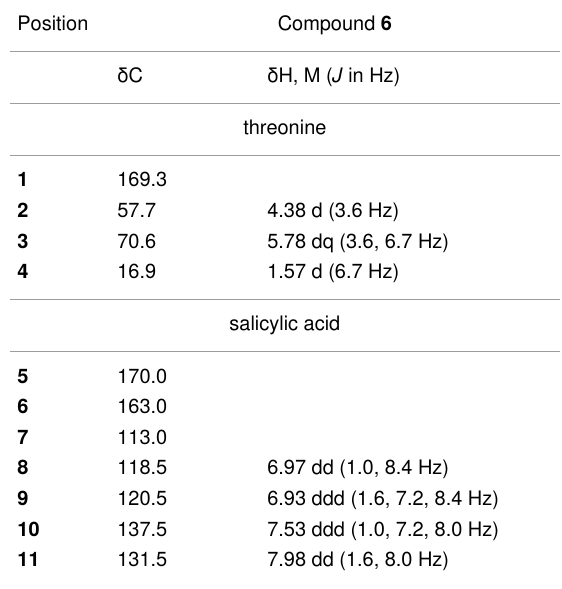
Table 2: 1 H and 13 C NMR spectroscopic data of isolated compound 6 in methanol- d 4